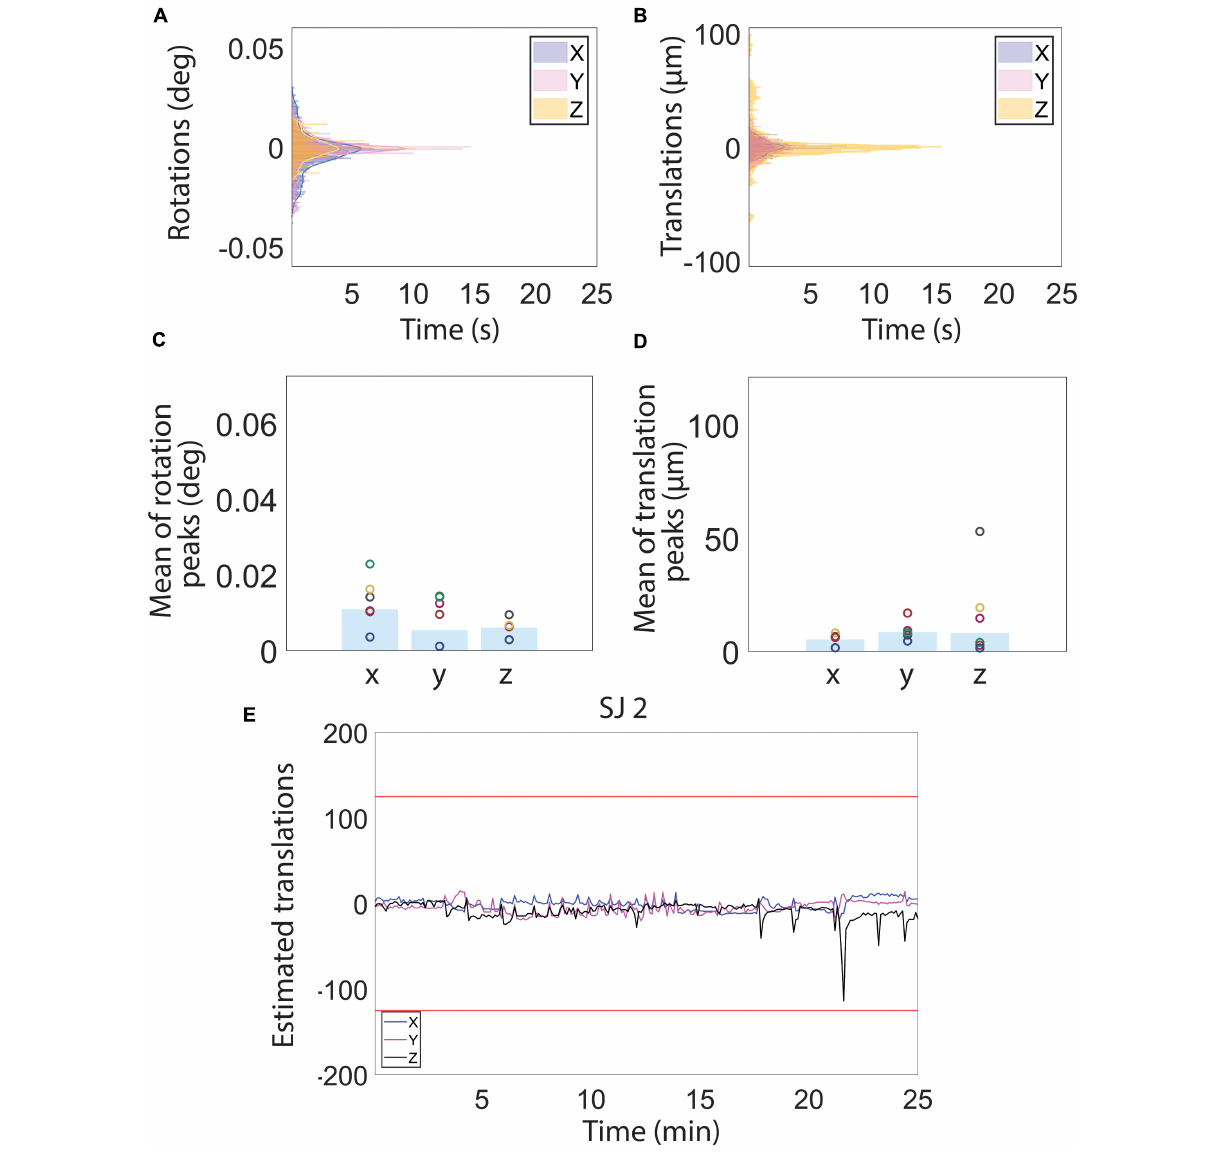
FIGURE 3 | Motion estimation derived from magnetic resonance images during resting state functional magnetic resonance imaging (fMRI) acquisition. (A–D) Histograms (A,B) and bar charts showing the peak mean of the estimated rotation (C) and translation (D) motion parameters. (E) Examples of estimated translation levels for a single subject (SJ 2). The red lines represent 1/4 of the voxel size. (See Figure 4 for motion traces of all other subjects). Low estimated translation values (smaller than 1/4 of voxel size) during the whole fMRI acquisition reflect a normal physiological state of the subjects, indicative, in turn, of low stress